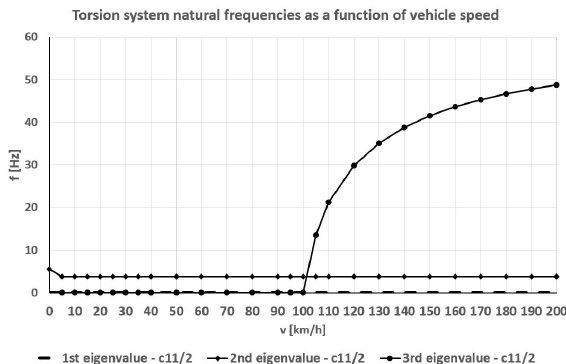
Figure 20. Natural frequencies as a function of ve- locity – c 11 / 2.